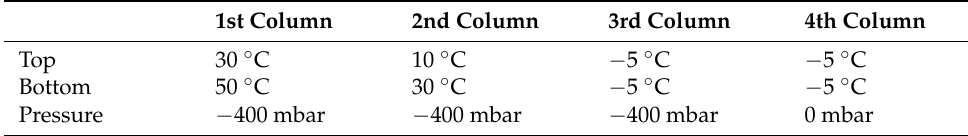
Table 4. Temperature settings of each column for Citra